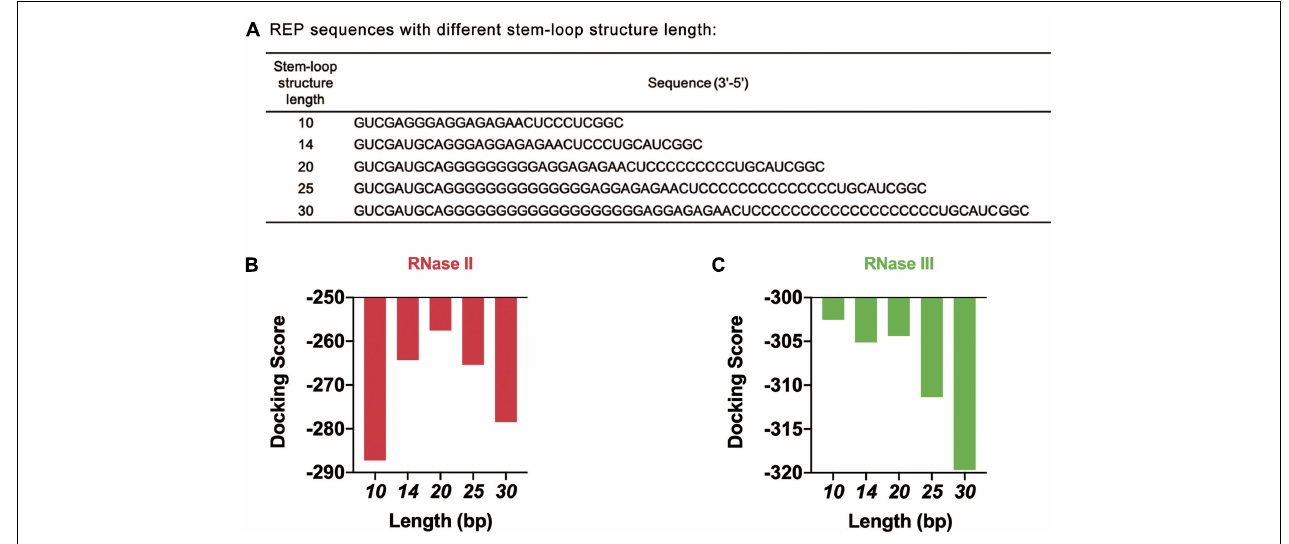
FIGURE 6 | Simulation results of REP sequences with different stem-loop structure lengths. (A) REP sequences with different stem-loop structure lengths. The model REP sequence was the sequence number 17. (B) Simulation results of RNase II with different REP sequences. These REP sequences had different lengths, which ranged from 10 to 30 bp. (C) Simulation results of RNase III with different REP sequences. These REP sequences had different lengths, which ranged from 10 to 30